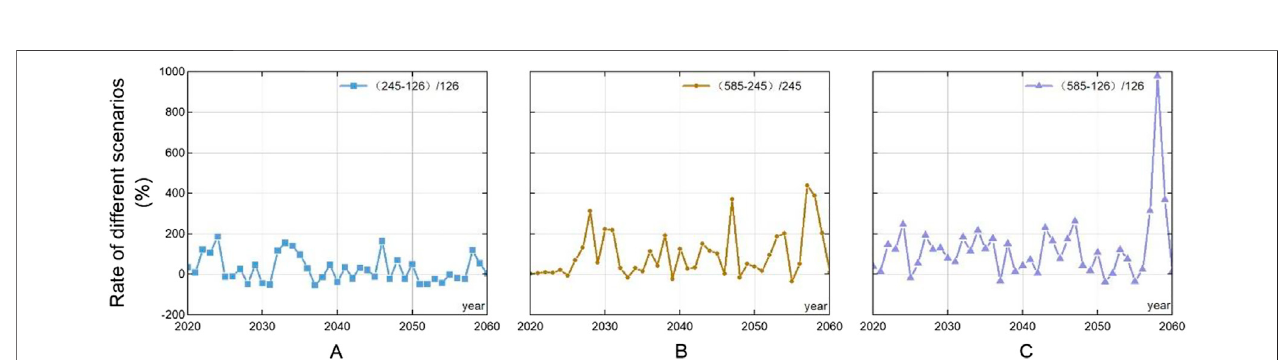
Frontiers in Earth Science |